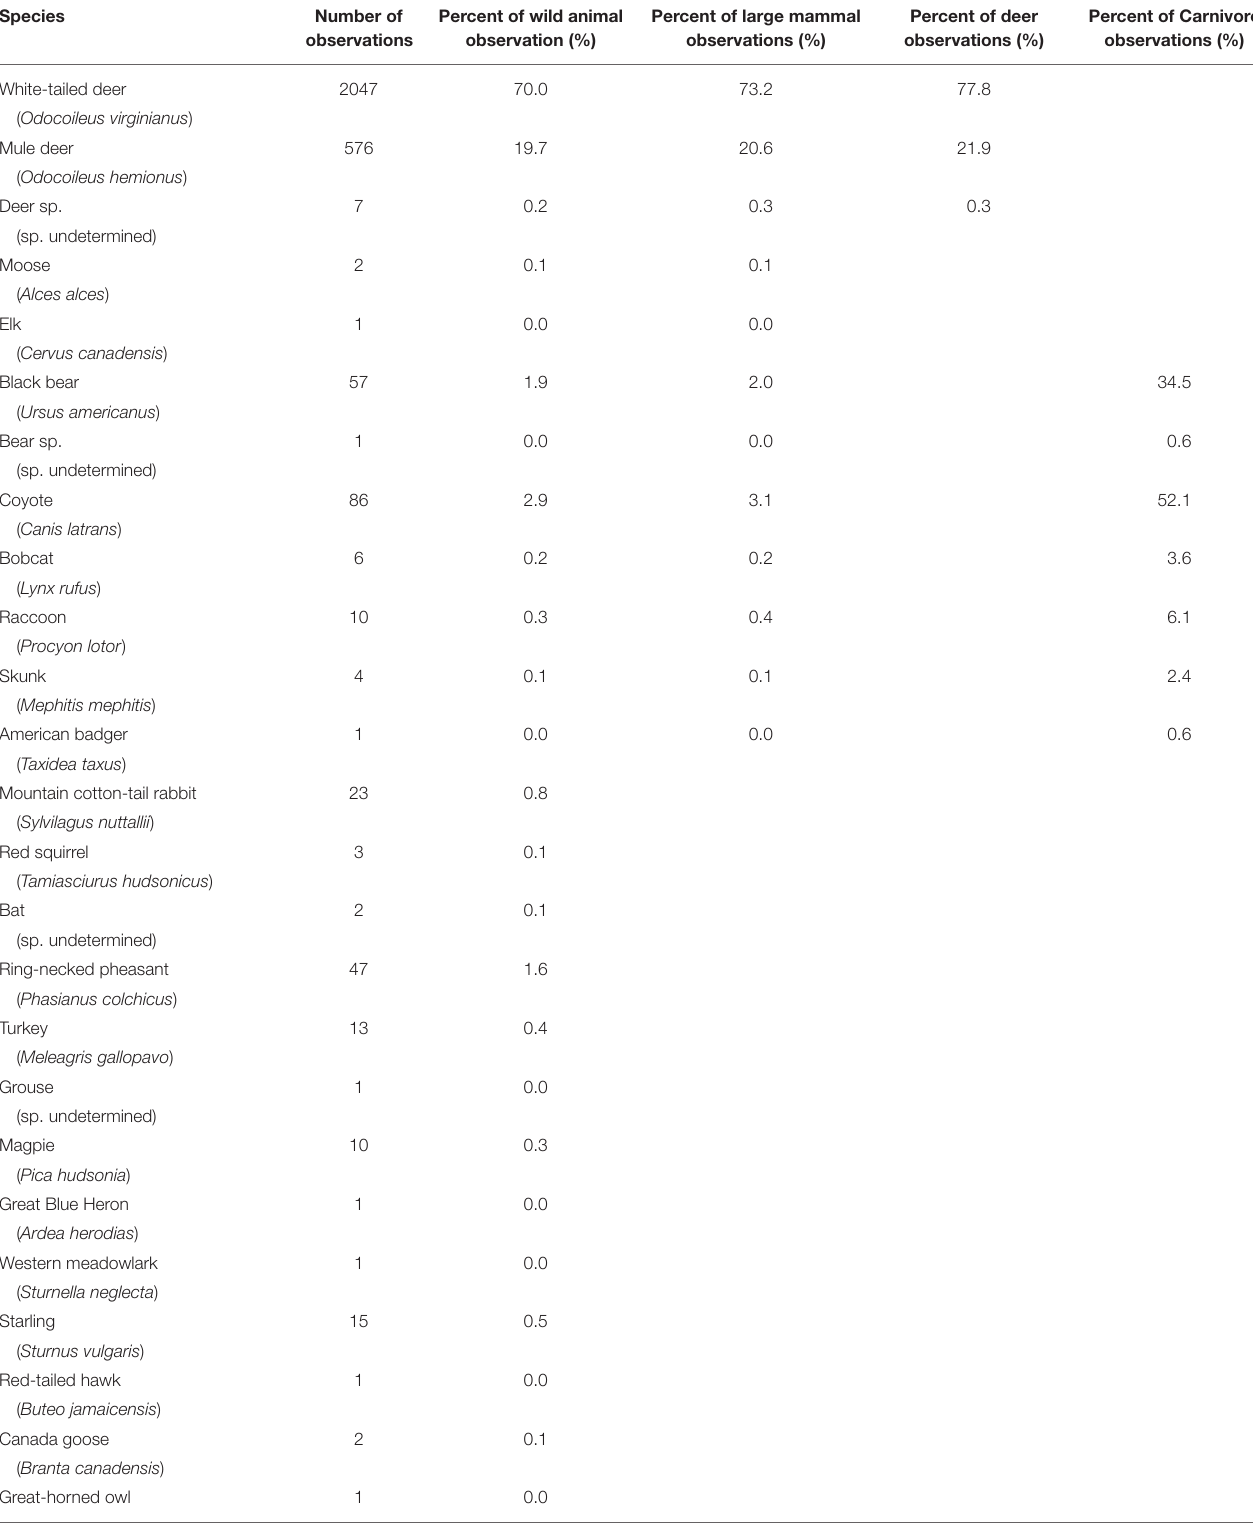
TABLE 4 | Total observations and group percentages of animal movements at both structure and control plots (combined total) in the study along US93 within the Flathead Indiana Reservation, Montana for April through November 2015. Species Number of Percent of wild animal Percent of large mammal Percent of deer Percent of Carnivore observations observation (%) observations (%) observations (%) observations (%) White-tailed deer 2047